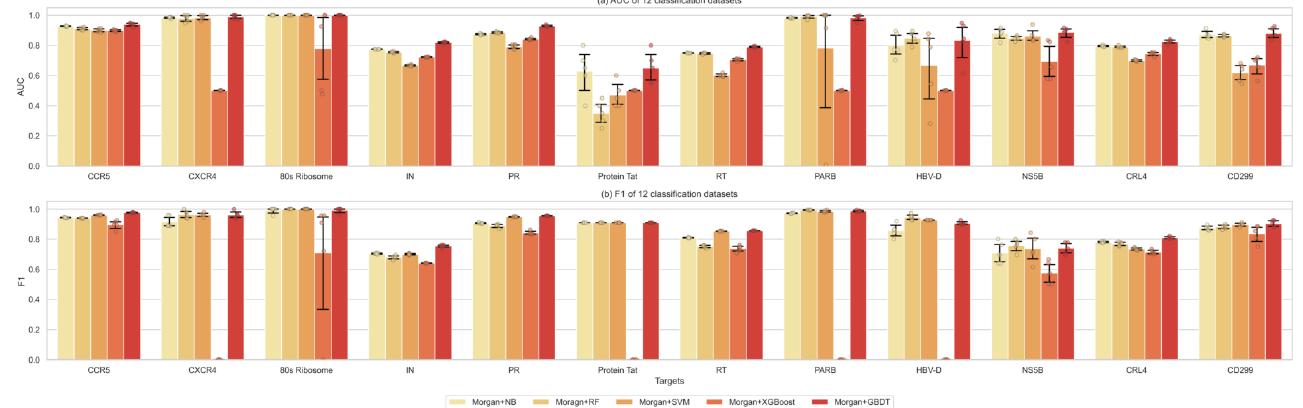
Figure 3. The performance comparison of different supervised learners. ( a ): the AUC values. ( b ): F1 metrics.